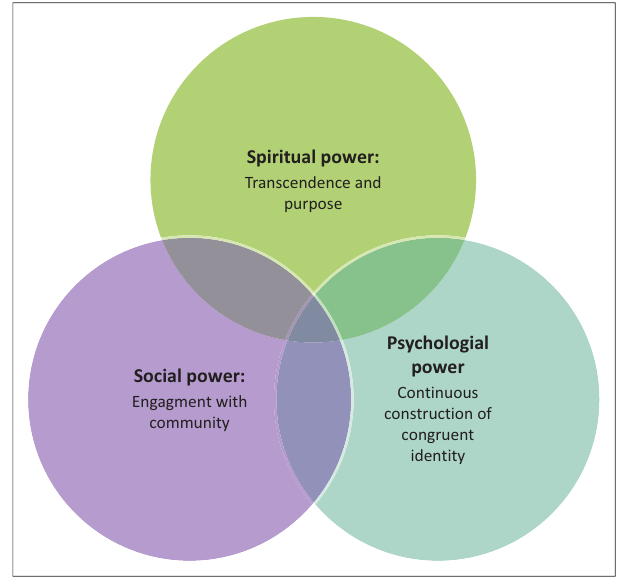
FIGURE 3: Emerging transformative model of